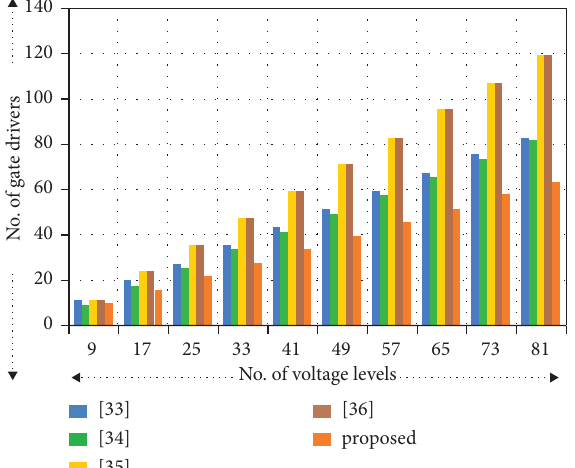
Figure 12: Comparison of number of current conducting devices required for various voltage levels in recent topologies vs. proposed topology.